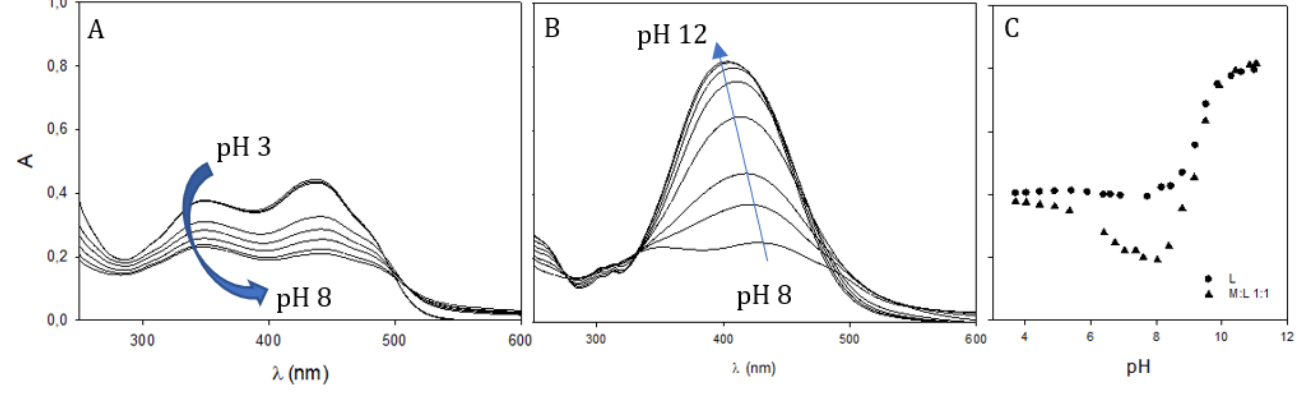
Figure 10. UV–Vis spectra of the Ga 3+ : 6 1:1 molar ratio at 25 °C (L = 50 μ M) on increasing pH. Panel ( A )—pH range of 3–8; panel ( B )—pH range of 8–12; panel ( C )—plot of absorbance at 405 nm vs. pH for the free ligand (circles) and the metal-ligand system (triangles).